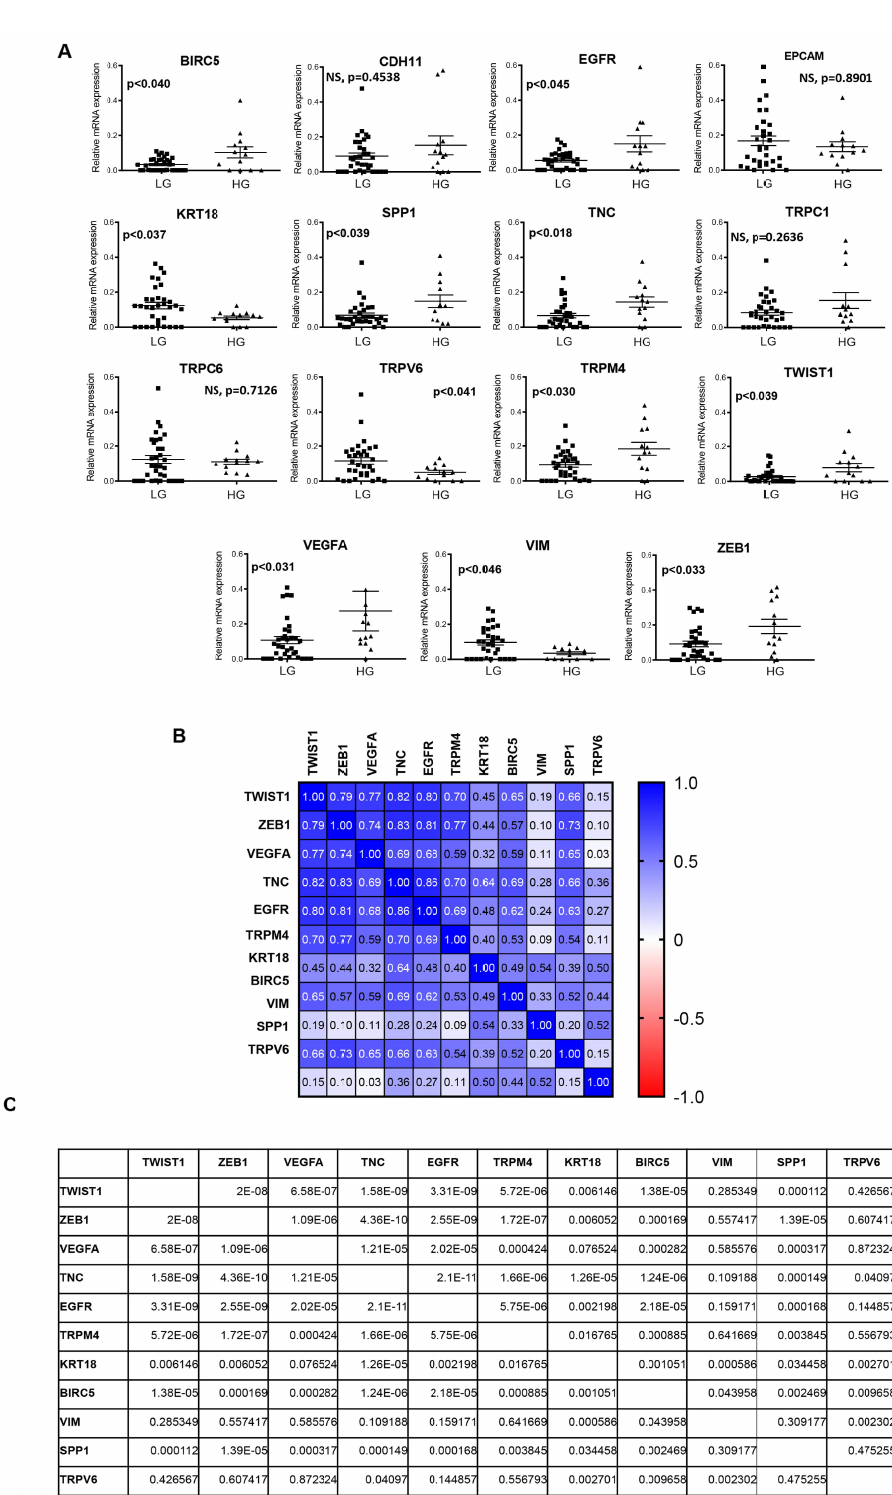
Figure 5. The gene expression analysis of the selected biomarkers. ( A ) The analysis was per- formed in the CTCs by stratifying patients according to high grade (HG) and low grade (LG). The Mann–Whitney t-test. p ≤ 0.05 was considered as statistically significant. ( B , C ) The Spearman correlation matrix of the selected biomarker candidates. NS = not statistically significant, p ≤ 0.05 was considered as statistically